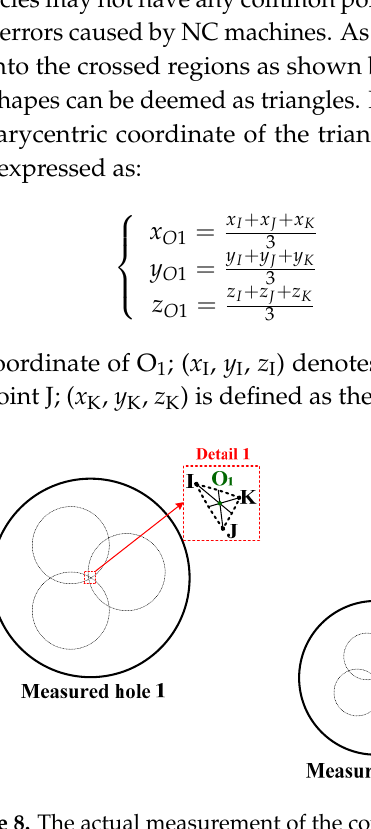
Figure 9. The calibration of the intrinsic parameters.